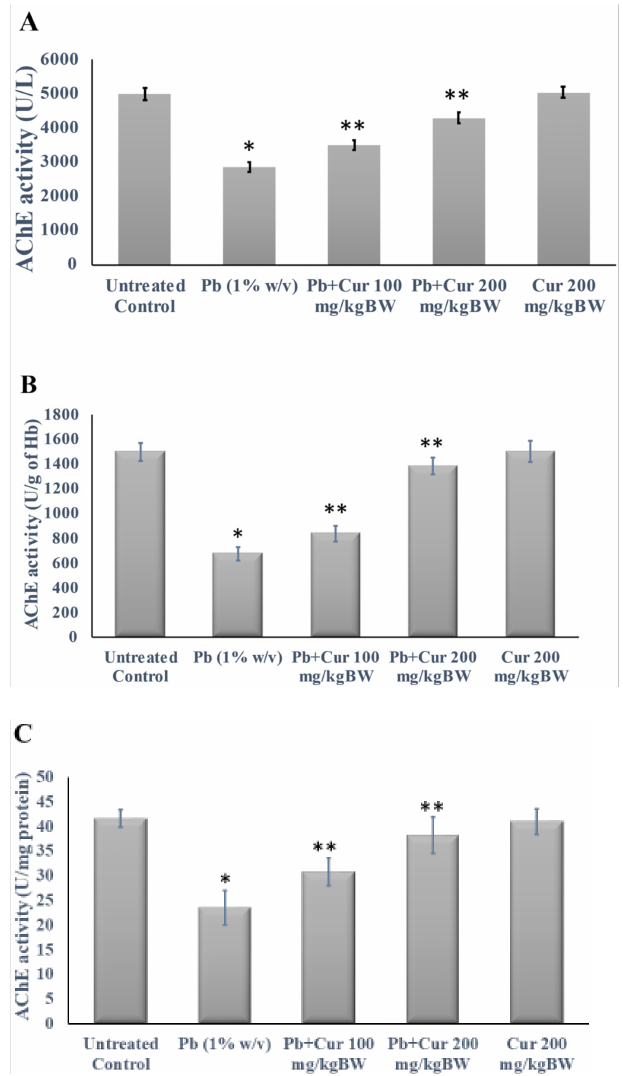
Figure 2. Effect of curcumin on cholinergic dysfunction caused by lead. ( A – C ) Acetylcholinesterase (AChE) activity in the plasma, RBC, and brain homogenate, respectively. The results are displayed as mean ± SEM ( n = 6). * p < 0.05 specifies a difference between control mice and Pb-treated mice. ** p < 0.05 compares between Pb-treated mice and Curcumin (Cur)-treated mice. On the contrary, the Pb-treated mice with Cur showed significantly ( p < 0.05) mod- ulated AChE dysfunction in the plasma, RBC, and brain homogenates (Figure